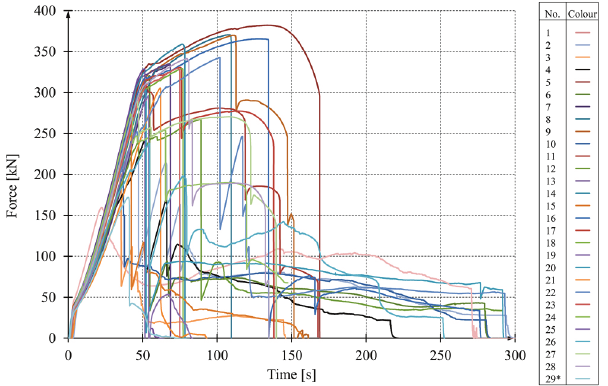
Fig. 18b. Force transferred by pile-concrete foundation anchorage connection over